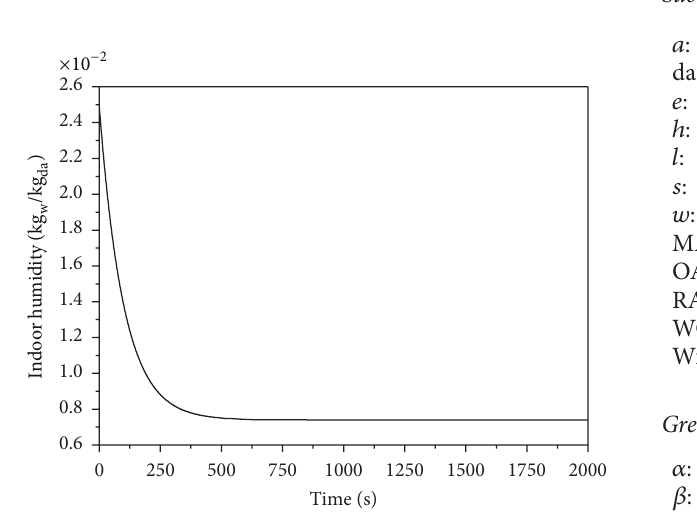
Figure 12: Zone humidity versus time for PID controller.